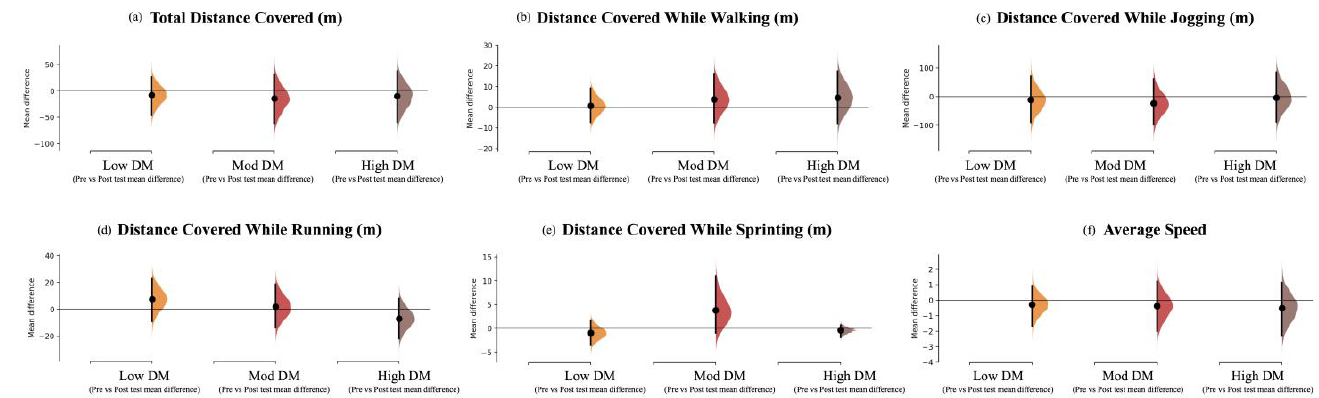
Figure 3. The mean difference (each mean difference is plotted as a bootstrap sampling distribution) for three comparisons pre- and post-measurements according to (i) GPET ball control, (ii) GPET passing execution, and (iii) GPET DM for the Low DM, Mod DM, and High DM tasks, as shown in the Cumming estimation plots above. The raw data are plotted on the upper axes. Mean differences are depicted as dots; 95% CIs are indicated by the ends of the vertical error bars [50].